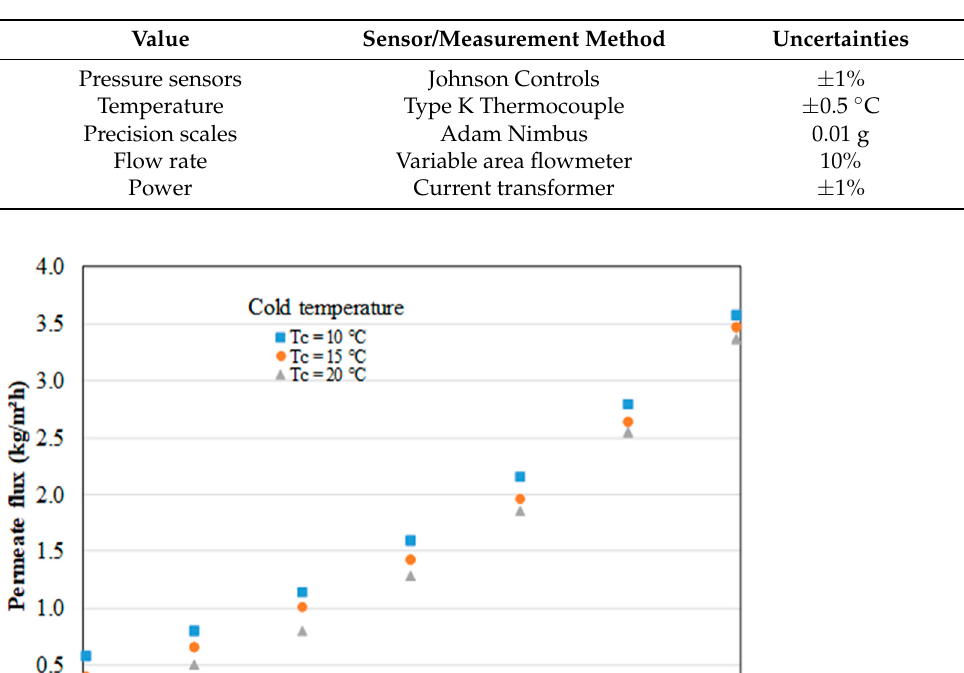
Table 2. Measurement methods and uncertainties.